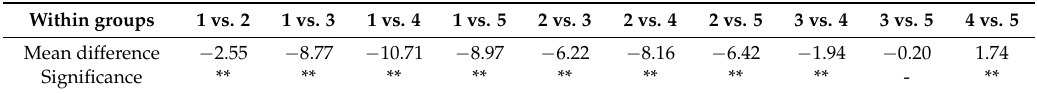
Table 11. Tukey’s HSD test results for moisture